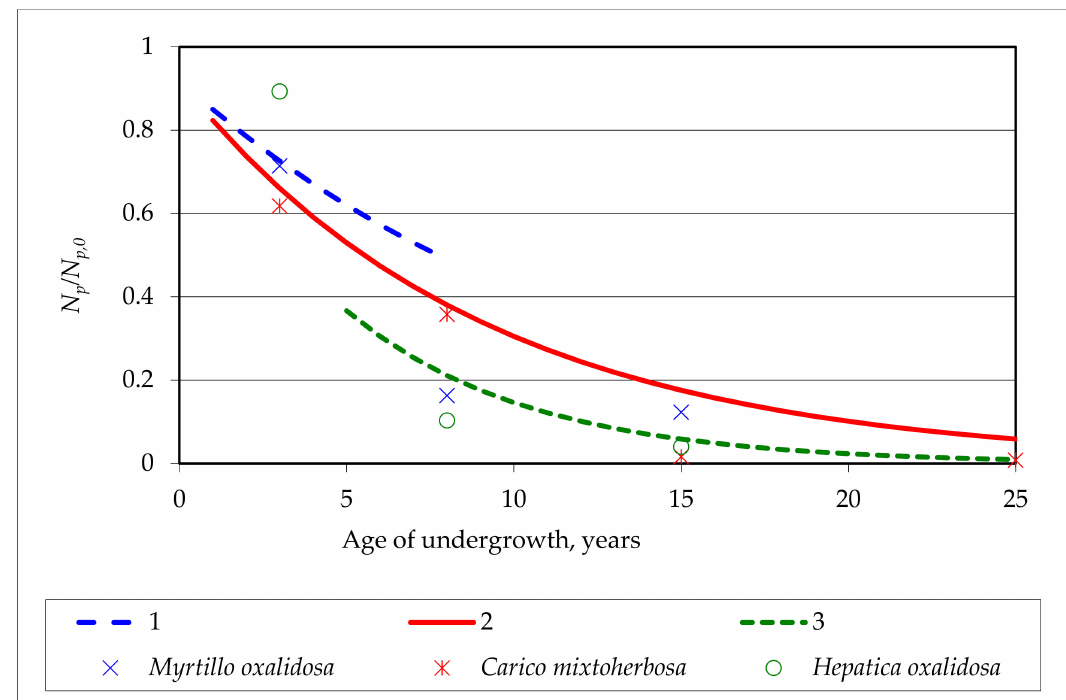
Figure 8. Relative amount of exponential dependence on the age of the pedunculate oak undergrowth compared with other authors’ observation data in different oak stands: 1—exponential curve to ∆ t = 3 year, 2—exponential curve to ∆ t = 5 year, 3—an exponential curve to ∆ t = 7 years. Points—data of observations